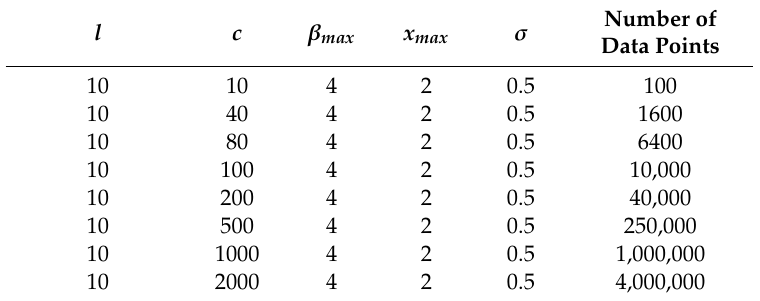
Table 1. Construction parameters of example data and access entrance of resource.